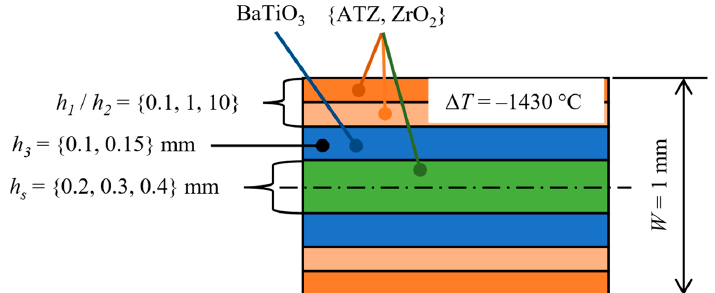
Figure 3. Scheme of the first optimization